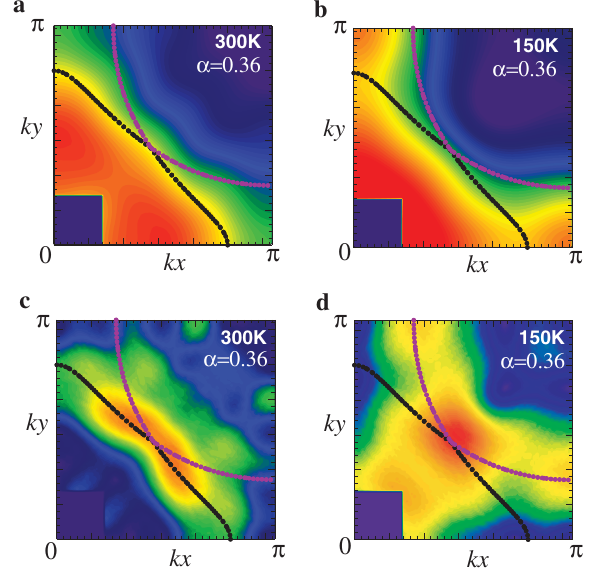
Fig. 4 Interpretation of Fig. 1a, b in terms of the nematic scenario shown in Fig. 3. a and c are the momentum distribution function n ( k ) and the magnitude of its derivative ∣ ∇ n ( k ) ∣ at 300 K in the fi rst quadrant of the Brillouin zone, respectively; b and d are the corresponding results at 150 K. A value of α controls the strength of nematicity and the conventional Fermi surface (ref. 9 ) is reproduced at α = 0; see Supplementary Note 2 for the precise de fi nition of α